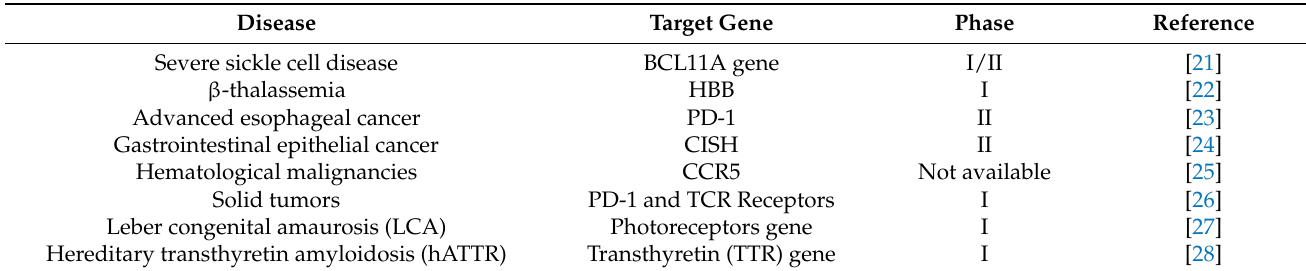
Table 1. CRISPR-based current clinical